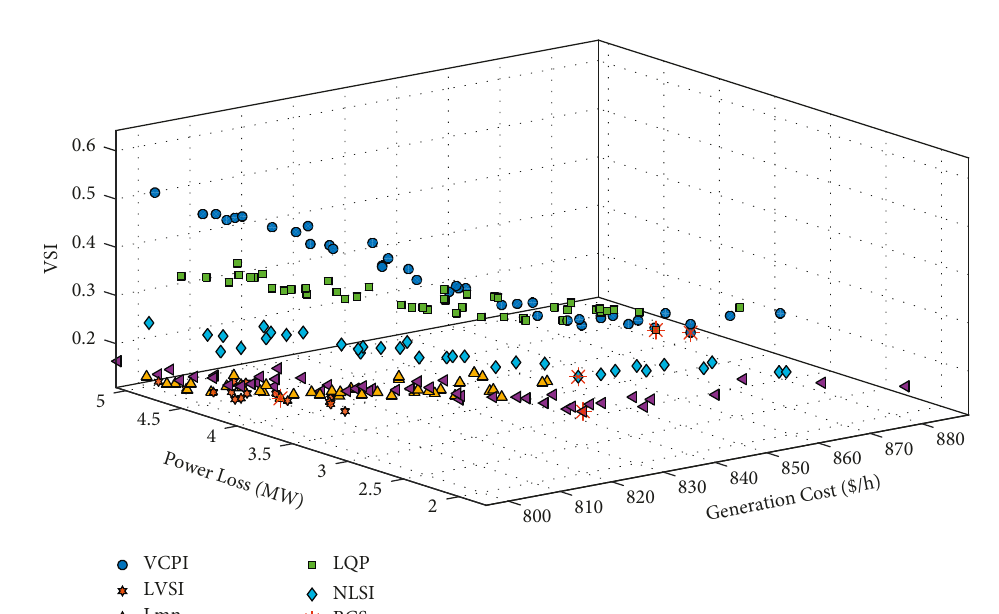
Figure 7: SC-1 Pareto-optimal solutions for the six case